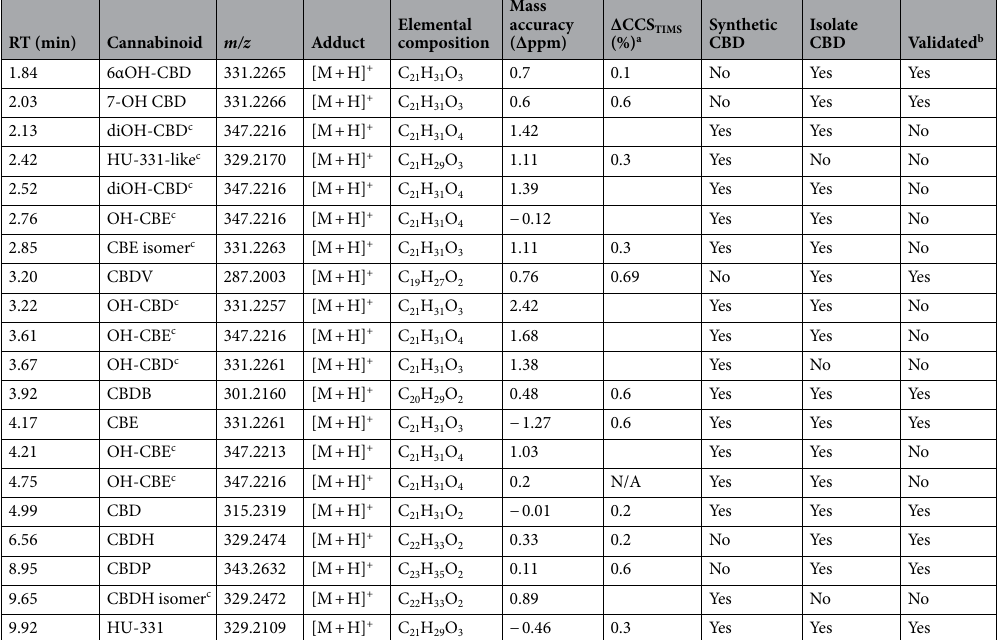
Table 3. Cannabinoids, impurities, and degradation products detected in CBD e-liquids stored for 4 weeks under stress conditions (40 °C/75% RH). CBD cannabidiol; CBDB cannabidibutol; CBDH cannabidihexol; CBDP cannabidiphorol; CBDV cannabidivarin; CBD-HQ, CBD hydroxyquinone (HU-331); CBE cannabielsoin; diOH‑CBD dihydroxy-cannabidiol; OH‑CBD hydroxy cannabidiol; OH‑CBE hydroxy- cannabielsoin. a ΔCCS (%) values are result of comparison between was estimated by comparing the measured CCS values in analysed samples and CCS values with that obtained using for the certified reference material (CRM) on the same instrument. b Compounds validated by a matching to an authentic standard based on retention time, exact mass measurement, isotopic pattern, collisional cross section, and MS 2 fragmentation. c Putative